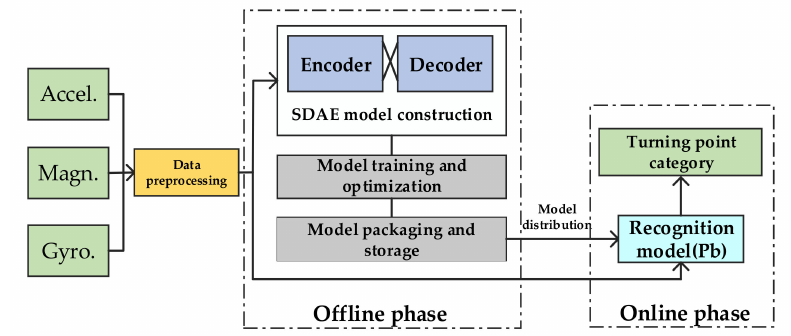
Figure 7. Infrastructure of the turning point detection